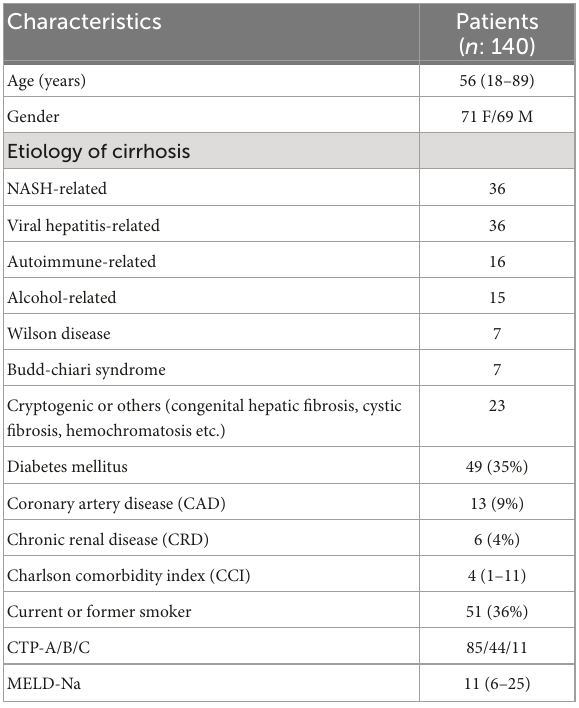
TABLE 1 Baseline clinical characteristics of the patients in the study